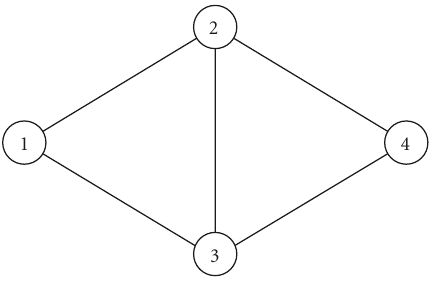
Figure 3: Example in which the wrong method of frame alignment can introduce singularities into the covariance